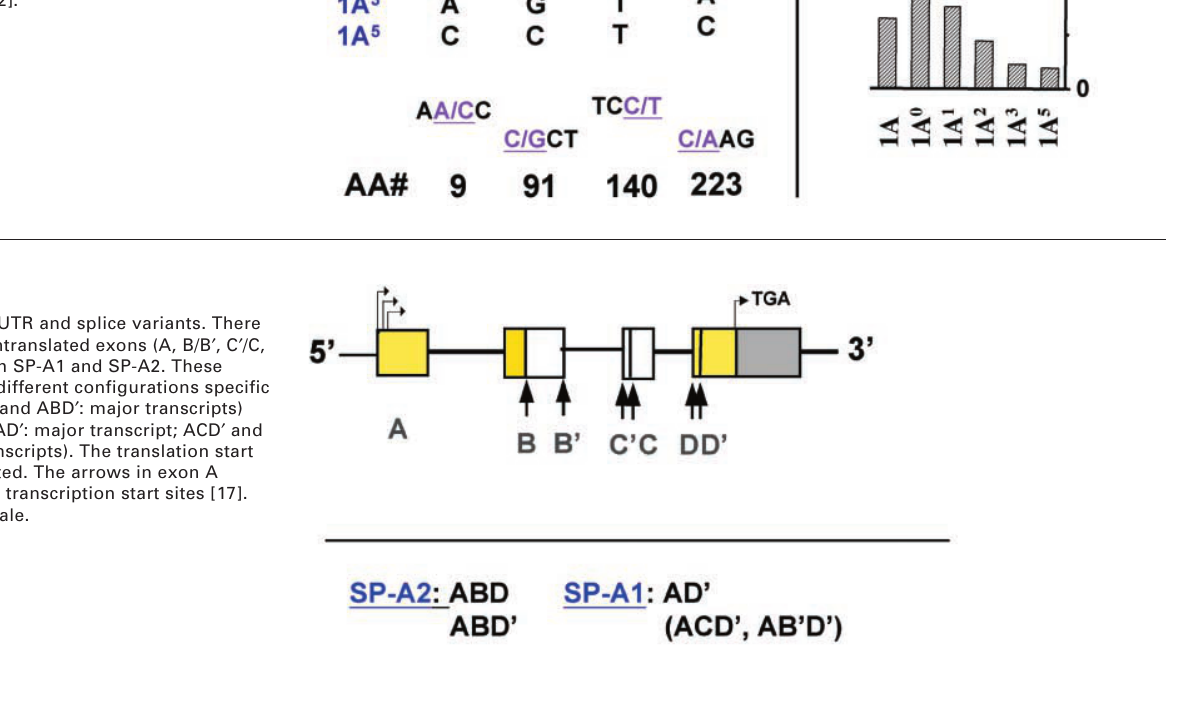
Human SP-A2 alleles: nucleotide differences and frequencies. Panel A denotes the most frequently observed SP-A2 alleles (1A, 1A 0 , 1A 1 , 1A 3 , 1A 5 ) and the nucleotide differences among these alleles. These differences are observed in codons for amino acids (AA) 9 (AA/CC), 91 (C/GCT), 140 (TCC/T) and 223 (C/AAG). The overall pattern of differences at the indicated locations determines each SP-A2 allele. Panel B depicts the frequency of the most commonly observed SP-A2 alleles in the general popula- tion (n>2000) [12].